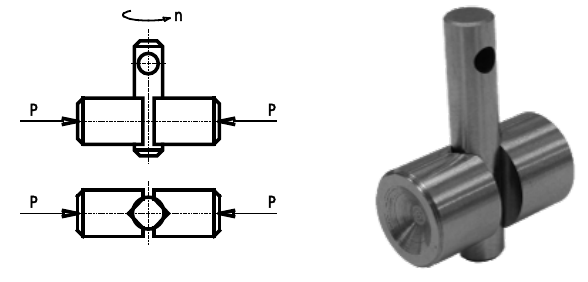
Figure 1. Pin and vee block tribosystem.